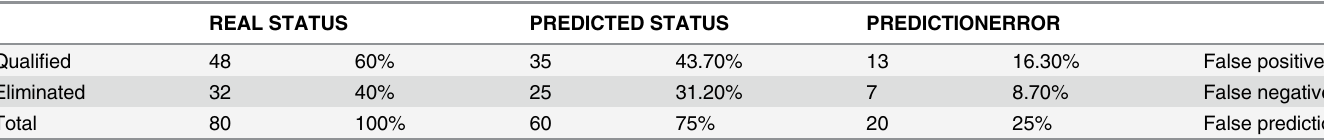
Table 4. Validation of the predictive logistic regressions by applying an independent dataset (including 80 horses having competed in endurance events in 2014). By applying a 70% probability of elimination in the regression calculations, the correct prediction rate was 75%. There were relatively few false negative predictions (8.70%), whereas the false positive rate was higher